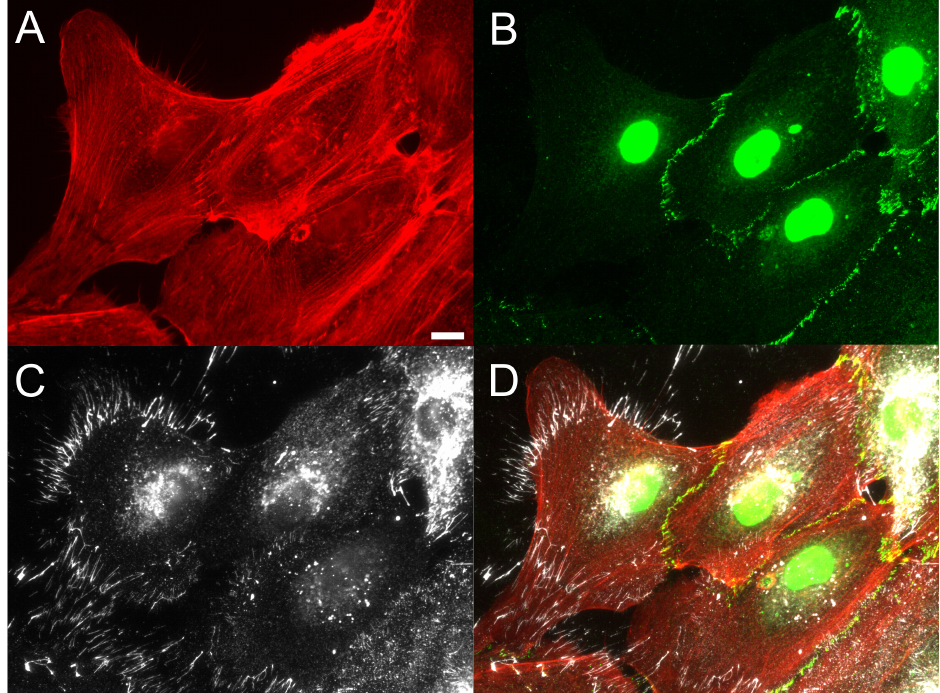
Figure 2. Fibronectin fibrils preferentially occur at cell voids in epithelial monolayers. Studies of incomplete epithelial cell monolayers indicated that FN fibril assembly preferentially occurred at free edges of the monolayer in the presence of 2 ng/mL TGF- β 1. Immunofluorescence images of ( A ) F-actin (red), ( B ) E-cadherin (green), and ( C ) FN (white) are shown (( D ) composite image). Scale bar 10 µ